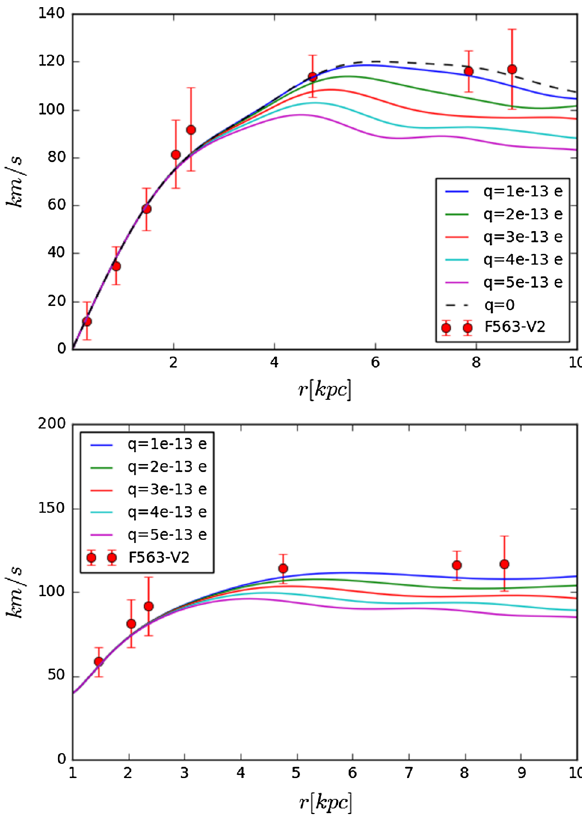
Fig. 4 Rotation curves derived from the coupled system of scalar and EM field equations. Upper panel show rotation curves derived from the monopole solution while the lower panel corresponds to the dipolar scalar configuration. Parameters characterizing the density profile of dark matter are those of the pivot neutral model and the value of the charge as indicated in plot labels